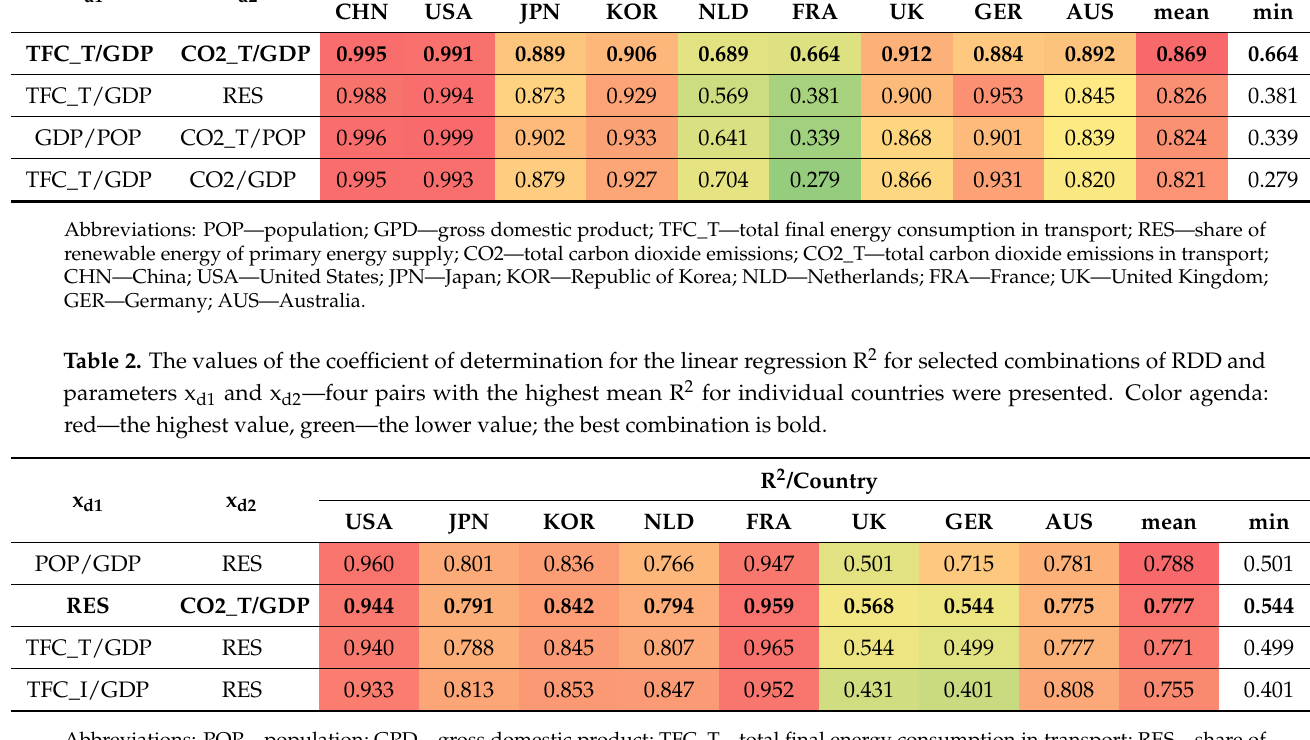
Table 1. The values of the coefficient of determination for the linear regression (R 2 ) for selected combinations of HPV and parameters x d1 and x d2 —four pairs with the highest mean R 2 for individual countries were presented. Color agenda: red—the highest value, green—the lower value; the best combination is bold. x d1